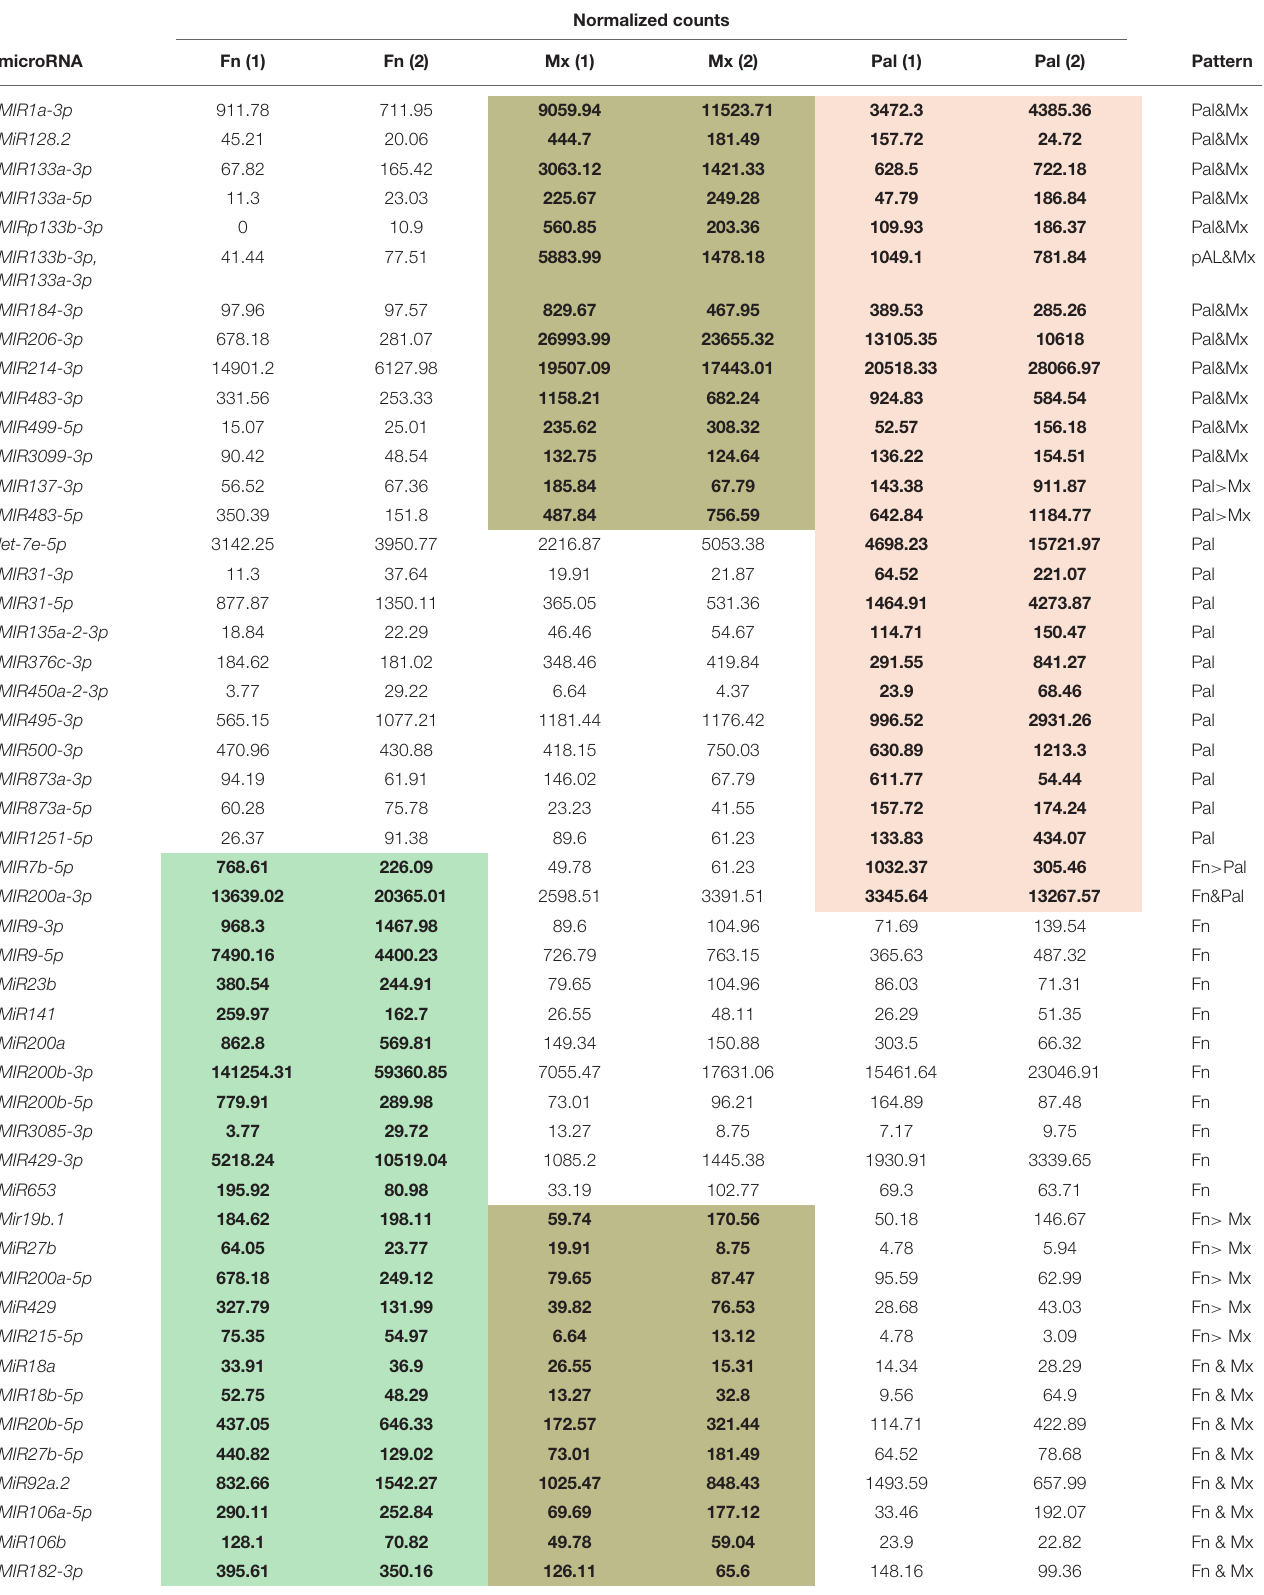
TABLE 1 | microRNAs that are differentially expressed between prominences at